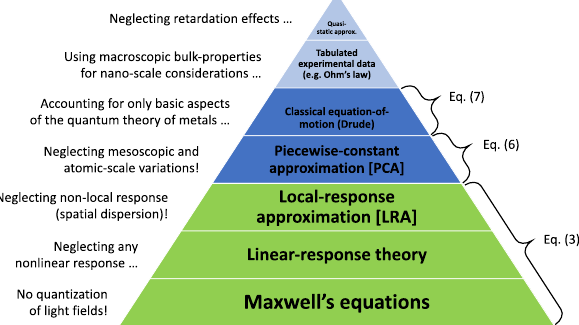
Figure 1: Schematic summary of common approximations inherent to the classical electrodynamics treatment of plasmonic phenomena at surfaces of metallic nanostructures, highlighting also